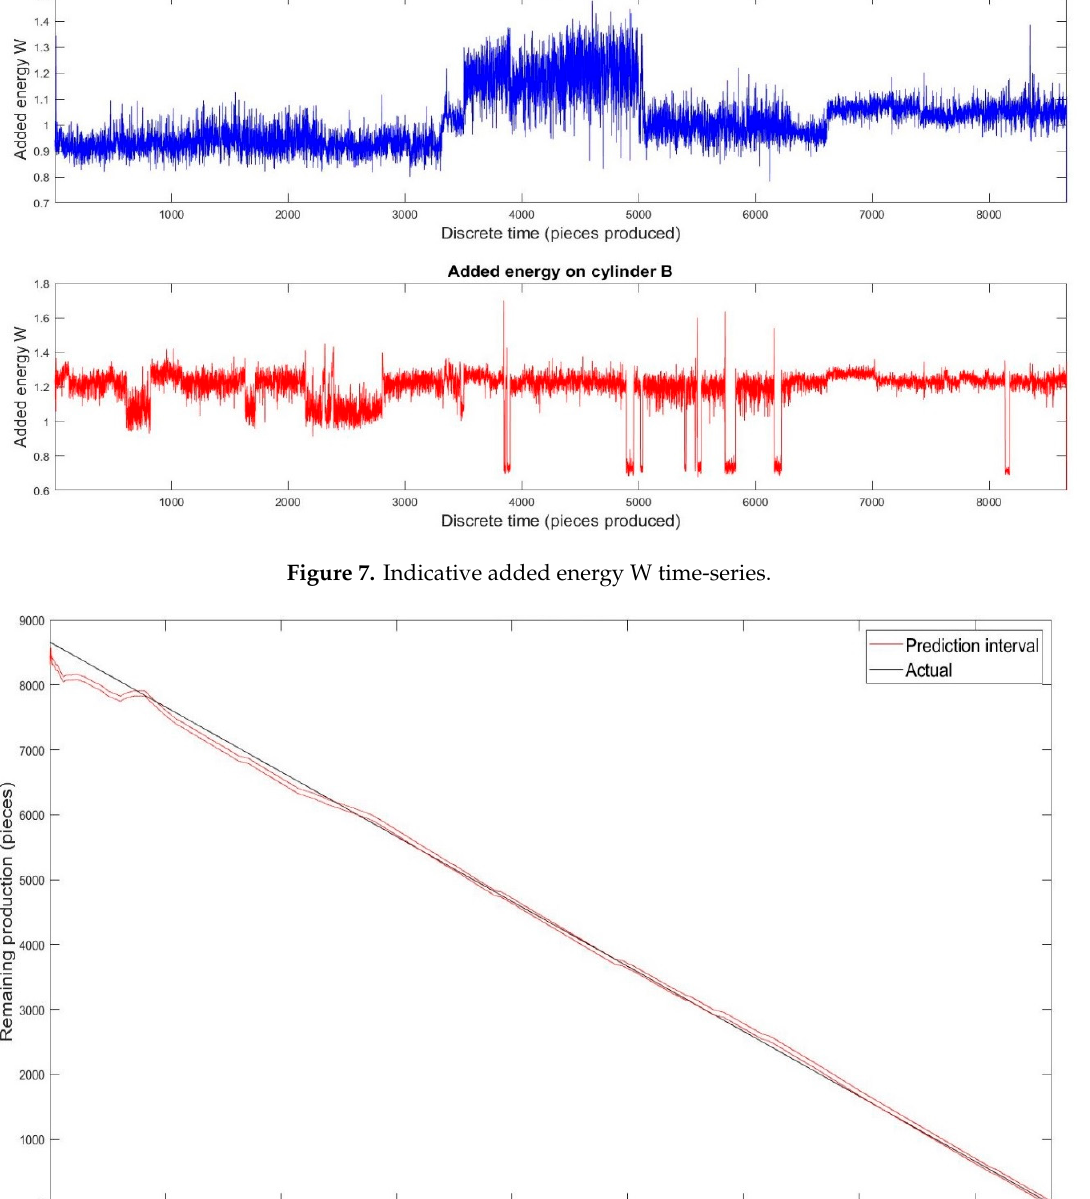
Figure 8. A sample of prediction simulation outcome.